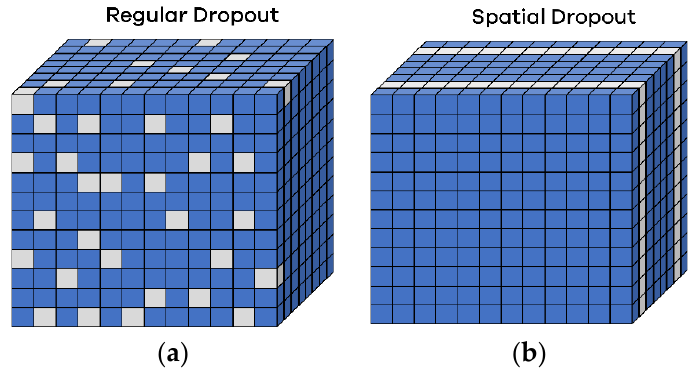
Figure 11. ( a ) Regular dropout channel deactivation; ( b ) spatial dropout channel deactivation.